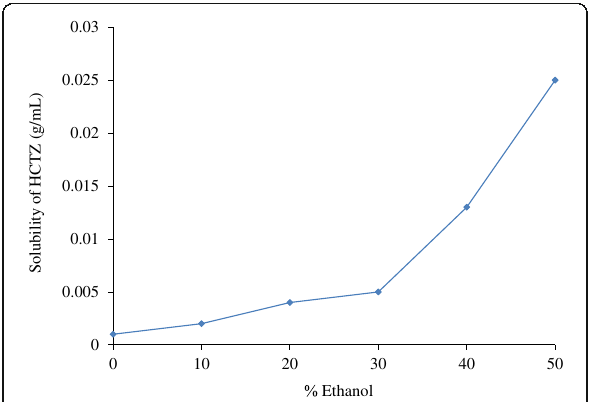
Fig. 12 Effect of ethanol concentration on the solubility of HCTZ in different hydro-alcoholic media (data from reference (Emeje et al. 2008))